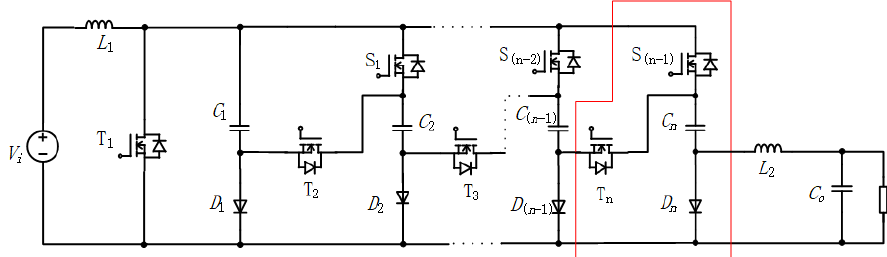
Figure 17. A Cuk-derived step-up/down SC converter in [35].